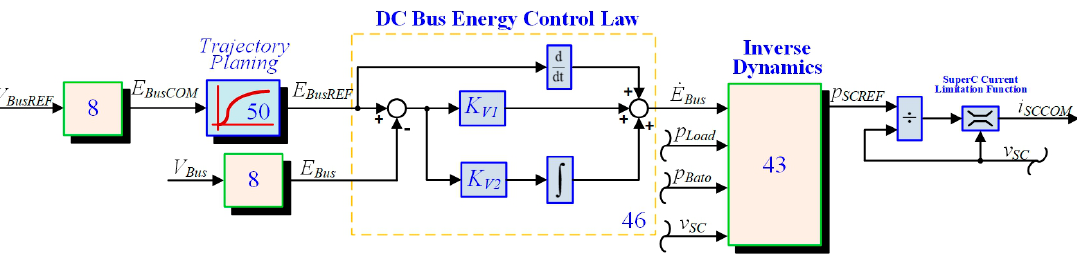
Figure 4. Proposed DC bus energy stabilization.